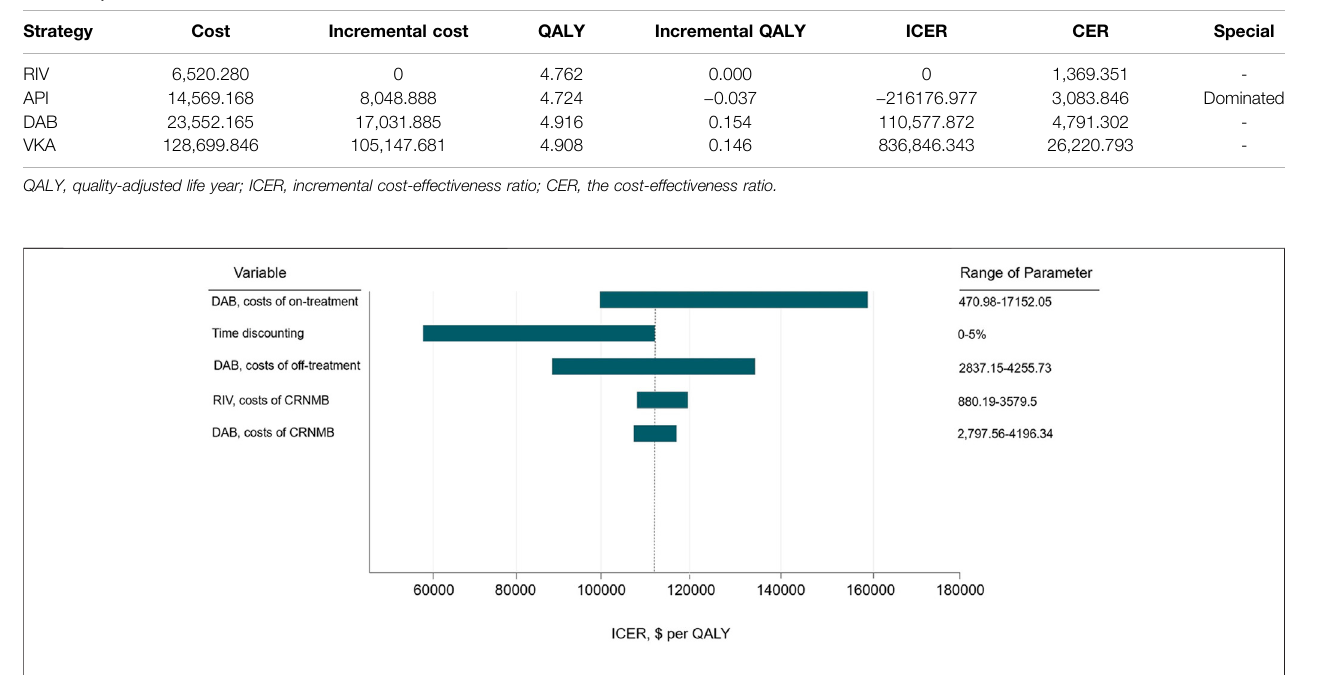
FIGURE 2 | One-way sensitivity analysis tornado diagram.